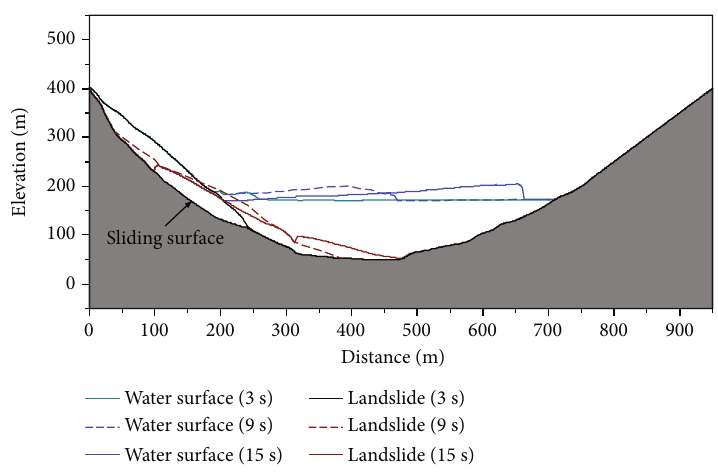
Figure 8: Formation process of maximum surge. Table 3: Empirical formulas for the maximum surge height caused by the landslide. Method Formula